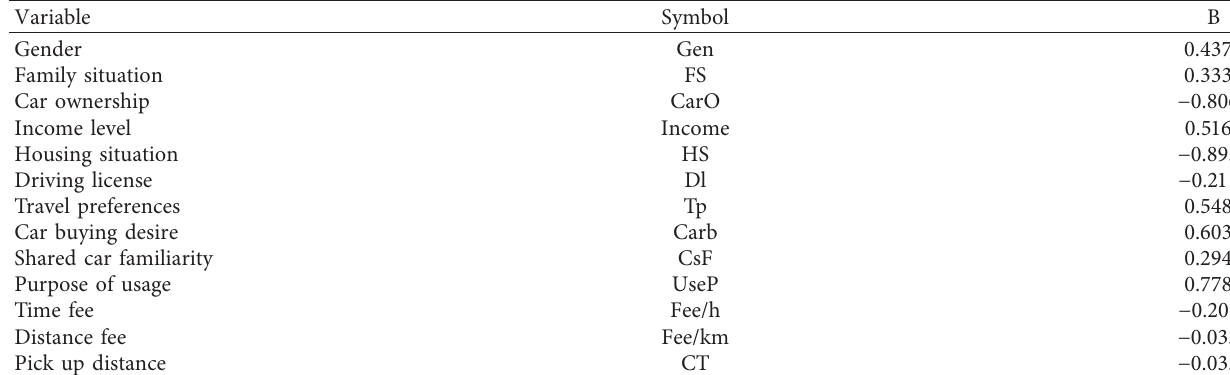
Table 4: Mixed logit simulation